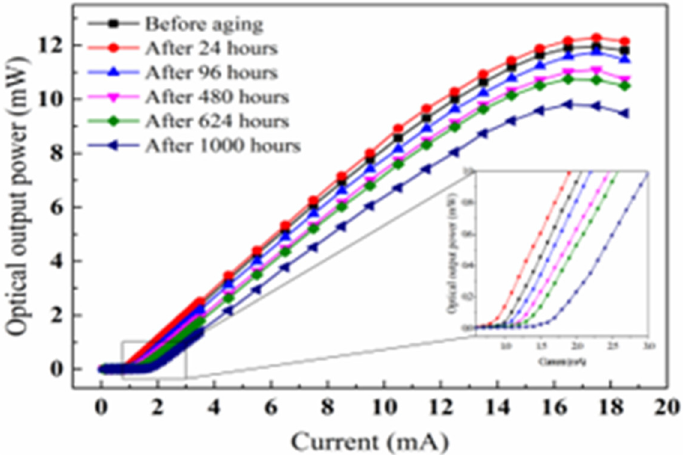
Figure 2. Optical output power versus bias current curves of VCSEL, before and after aging.